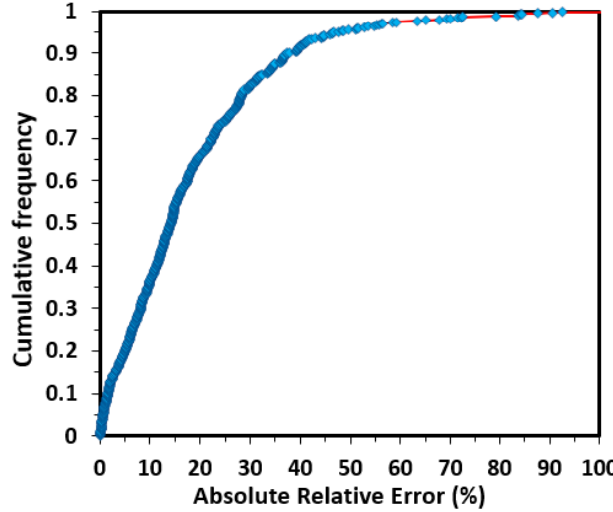
Figure 9. Cumulative frequency of absolute relative error for total data.